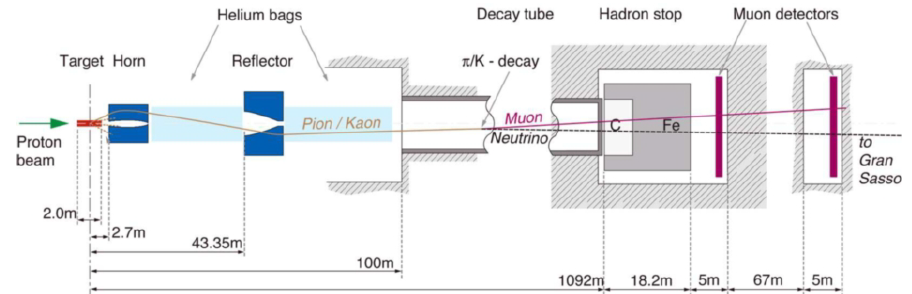
Figure 1. Layout of the CNGS neutrino